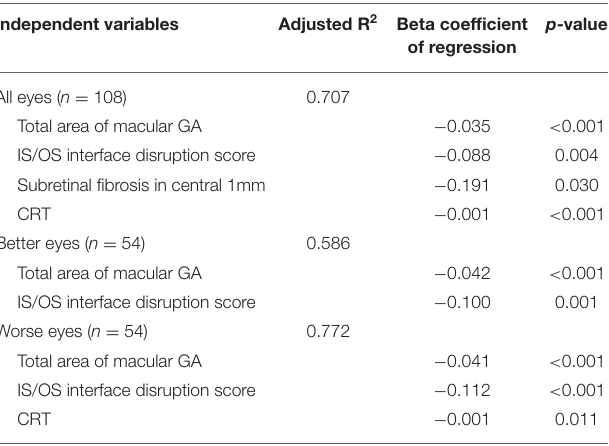
TABLE 5 | Multiple regression analysis of contrast sensitivity and morphologic parameters. Independent